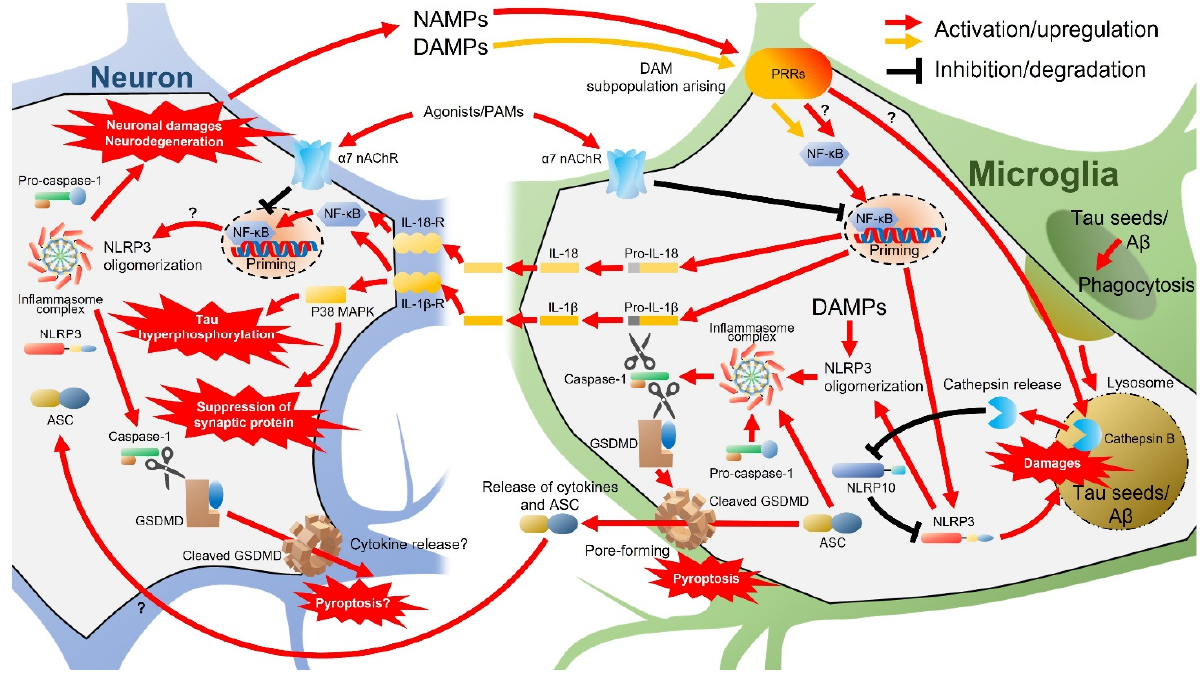
Figure 5. Neuroinflammation and related signaling pathways and molecules. ASC, apoptosis-associated speck-like protein containing a caspase recruitment domain; A β , amyloid β ; DAM, disease-associated microglia; DAMPs, damage-associated molecular patterns; GSDMD, Gasdermin D; IL, interleukin; MAPKs, mitogen-activated protein kinases; nAChRs, nicotinic acetylcholine receptors; NAMPs, neurodegeneration-associated molecular patterns; NLRP, NOD-, LRR-, and pyrin domain-containing; PRRs, pattern recognition receptors.